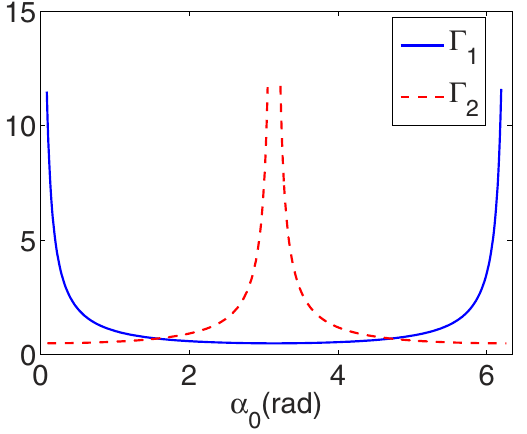
Figure 4. Enlargement ratios Γ 1 and Γ 2 versus the rotation angle α 0 . Γ 1 and Γ 2 are presented by the solid and dashed lines,